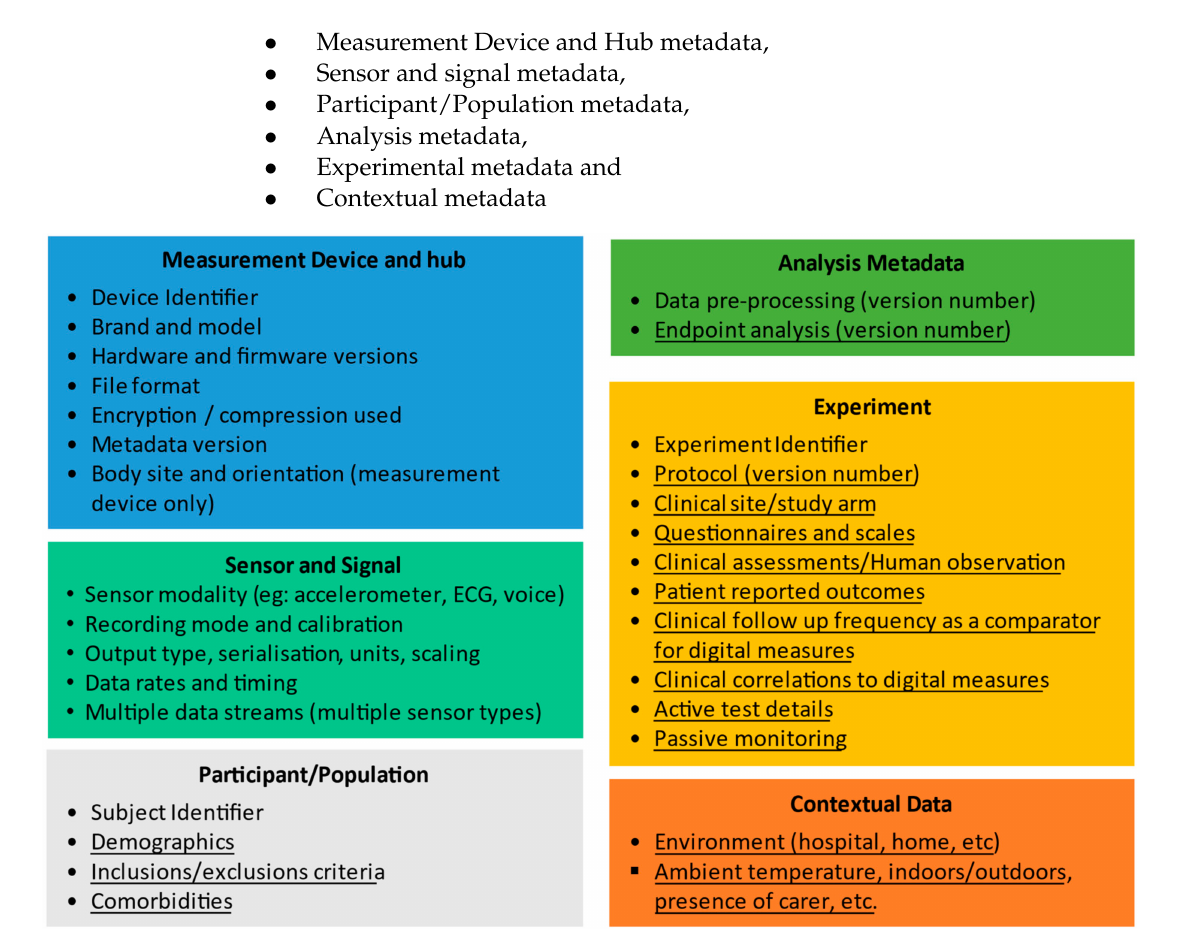
Figure 1. A summary of the metadata elements needed to describe the collection of data from digital health technologies in a clinical trial setting. Underlined elements are application dependent and non-underlined items are application independent. The Patient ID and Experiment ID in the application-dependent metadata link to the application-dependent metadata. The “device” elements are required for the measurement device (e.g., a wearable) but also hub (might be a smartphone + app) that works with the